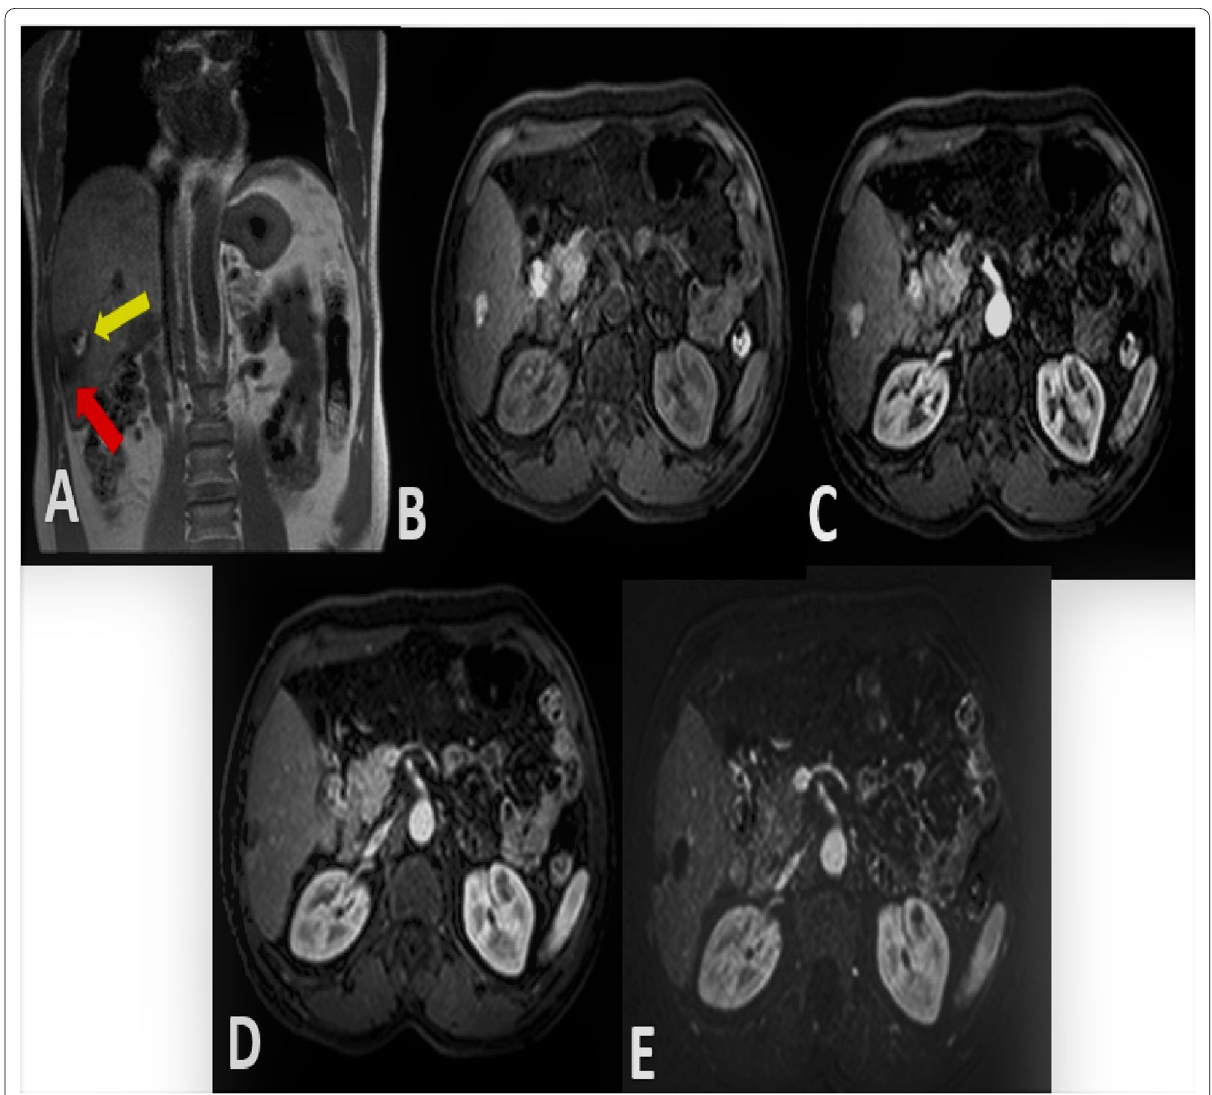
Fig. 6 A 66‑years‑old male patient with cirrhosis having RF ablation for right lobe focal lesion, dynamic MRI was done with subtraction technique 1 month after RF ablation, a coronal T1WI showing bright signal of the ablated Lesion (yellow arrow) with hypointense signal of the track (red arrow), b coronal T1WI showing bright signal of the ablated Lesion, c axial dynamic T1WI Early Arterial post contrast showing bright signal of the Lesion possibly due to preexisting bright signal or due to tumoral enhancement, d axial dynamic late arterial phase the ablated site appeared inconspicuous becoming isointense to the rest of the liver parenchyma, e subtraction MRI confirmed non enhancement with well ablation of the lesion removing the native T1 signal as well as background suppression of the lesion in relation to the enhanced liver parenchyma increasing the degree of